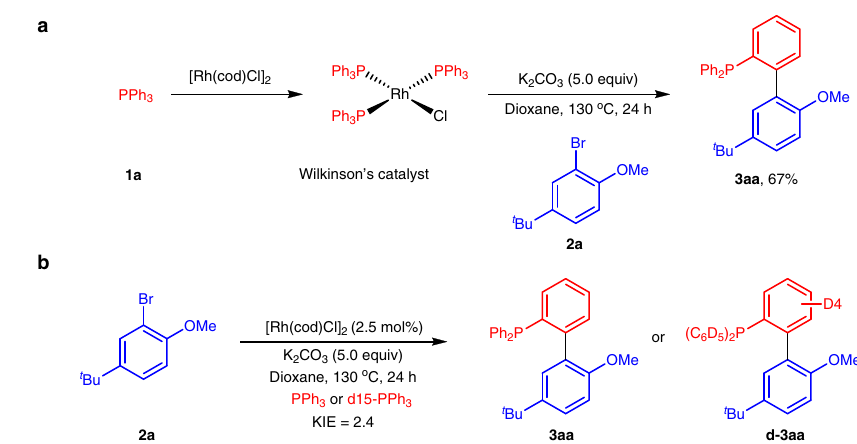
Fig. 6 Mechanistic experiments. a Investigation of Wilkinson ’ s catalyst as a key intermediate. b KIE experiments of 1a and d15- 1a